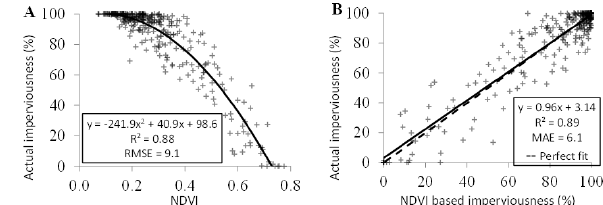
Figure 1. Relationship between NDVI and actual imperviousness for sample area (a) , and relationship between NDVI based imper- viousness and NDVI based imperviousness for sample area (b) . RMSE=Root Mean Squared Error, MAE = Mean Absolute